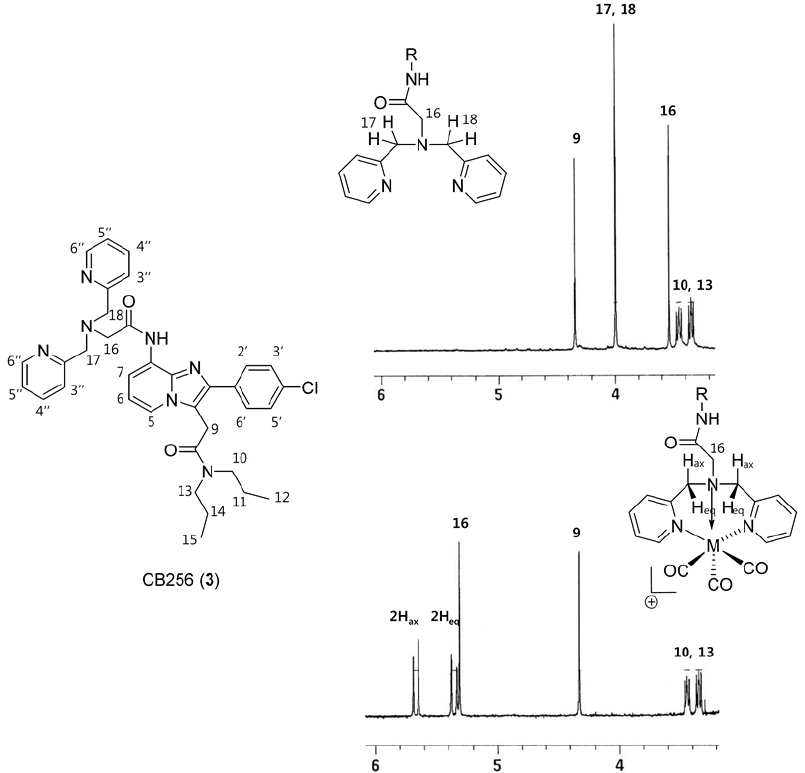
Figure 1. Section of the 1 H-NMR spectra between 6.0 and 3.2 ppm of the precursor 3 ( upper ) and of the “cold” rhenium complex 2 ( bottom ).